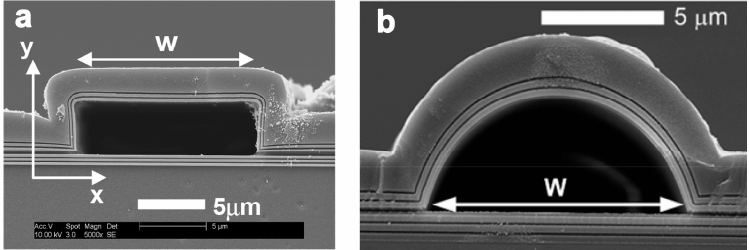
Figure 2. Scanning electron microscope (SEM) images of hollow-core anti-resonant reflecting optical waveguides (ARROWs) with ( a ) rectangular and ( b ) arch-shaped cross sections fabricated by surface micromachining process. Reprinted with permission from [33]. Copyright (2005) OSA.